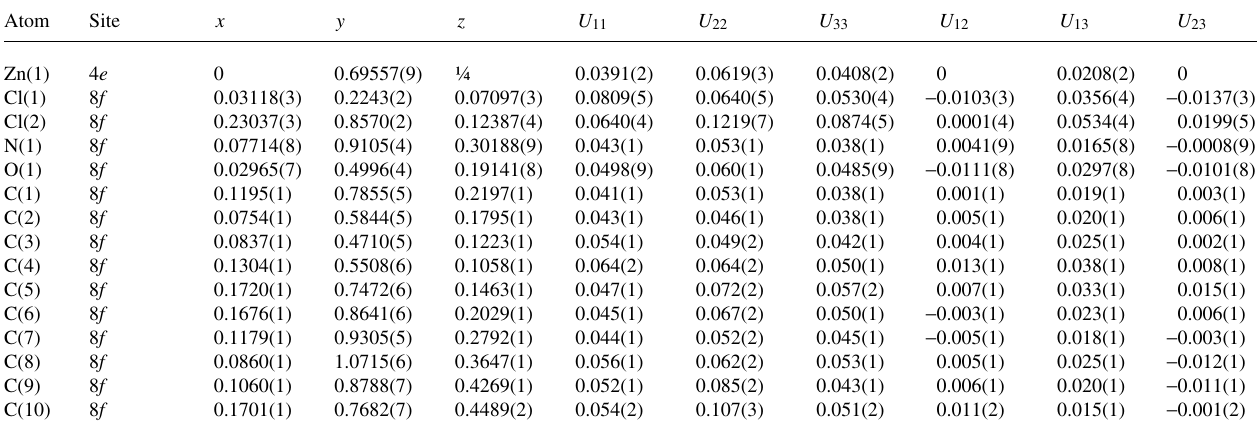
Table 3. Atomic coordinates and displacement parameters (in Å 2 )